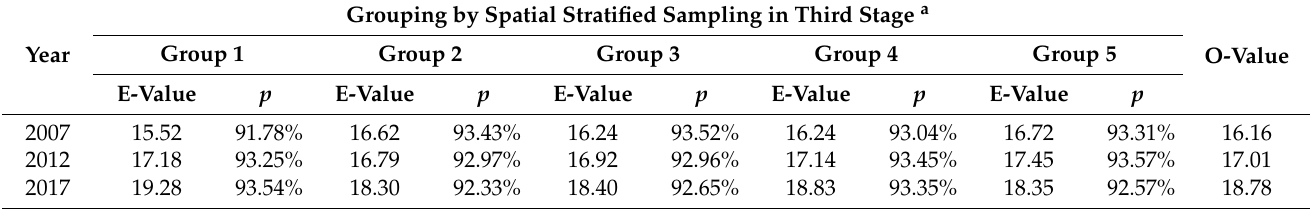
Table 5. Estimation results of the forest volume by spatial stratified sampling in the third stage.